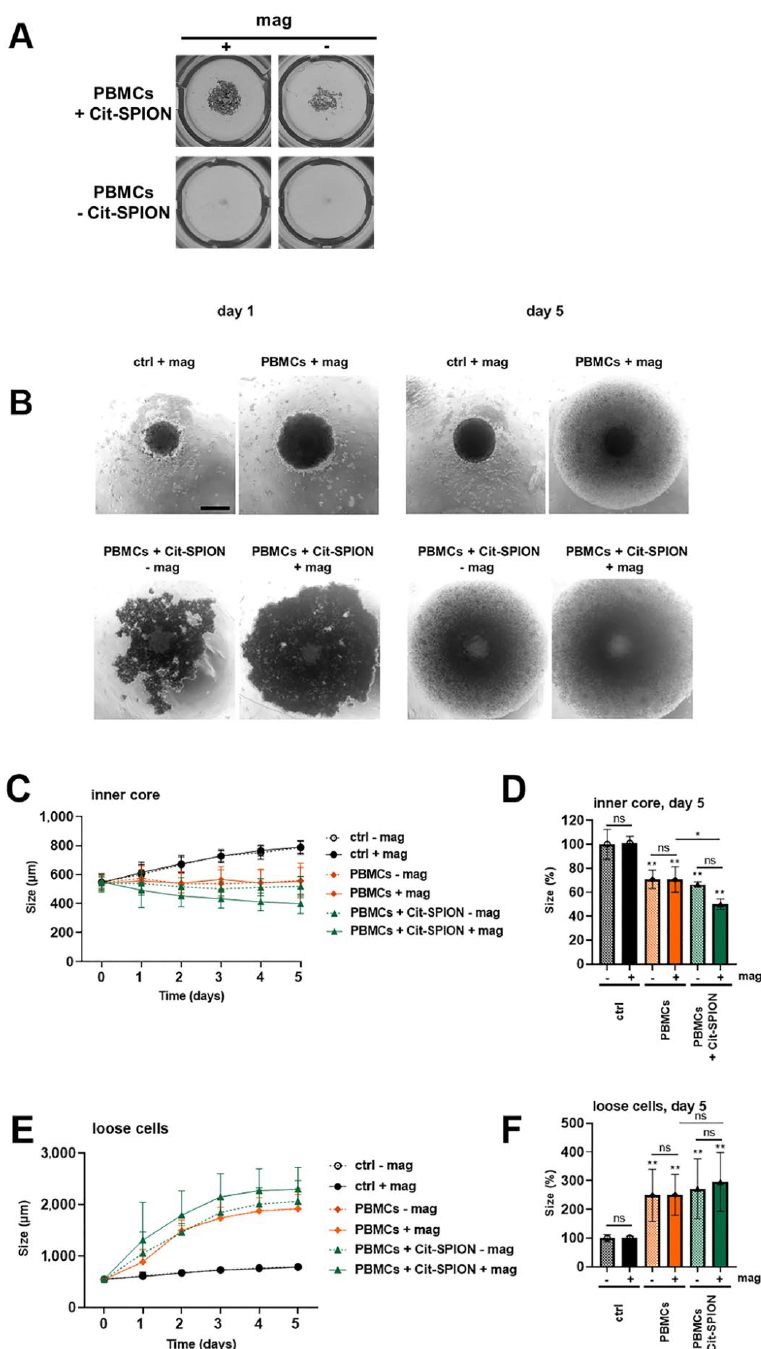
Figure 6. Magnetic accumulation of Cit-SPION with immune cells in a dynamic system. Spheroids were cultured for 3 days, and placed in a peristaltic system connected to a MIVO ® chamber. Media, Cit-SPION-loaded or non-loaded PBMCs were pumped for 1 h with 1.08 mL/min in the presence or absence of a magnetic field; afterwards, the spheroids were harvested from the chambers, including the surrounding medium. Macroscopic ( A ) and microscopic ( B ) images of spheroids and enriched PBMCs from the chamber after 1 h of pumping ( A , B ) ( left ) or 5 days of incubation ( B ) ( right ). ( C , D ) The size of the inner core (compact tumor spheroid) was evaluated separately from the surrounding detached cells ( E , F ). The experiment was performed three times. The mean values with standard deviation are shown. Significances were calculated using the two-way ANOVA test with * p ≤ 0.05, ** p ≤ 0.05, ns =